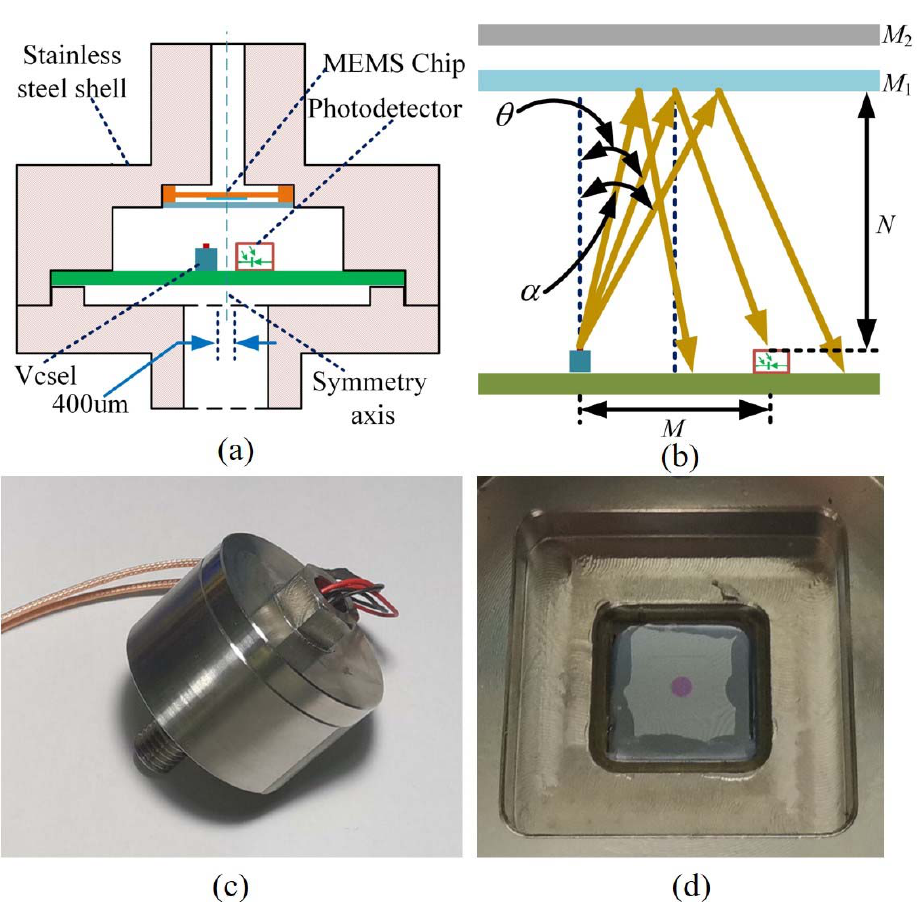
Figure 7. ( a ) The schematic diagram of the stainless-steel package, ( b ) the schematic diagram of optical path, ( c ) the stainless-steel package, ( d ) the pressure sensor installation.